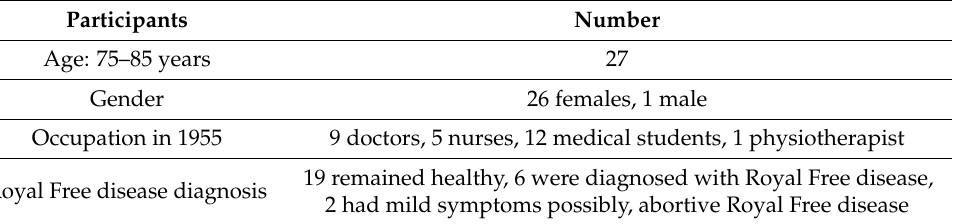
Table 1. Study Group